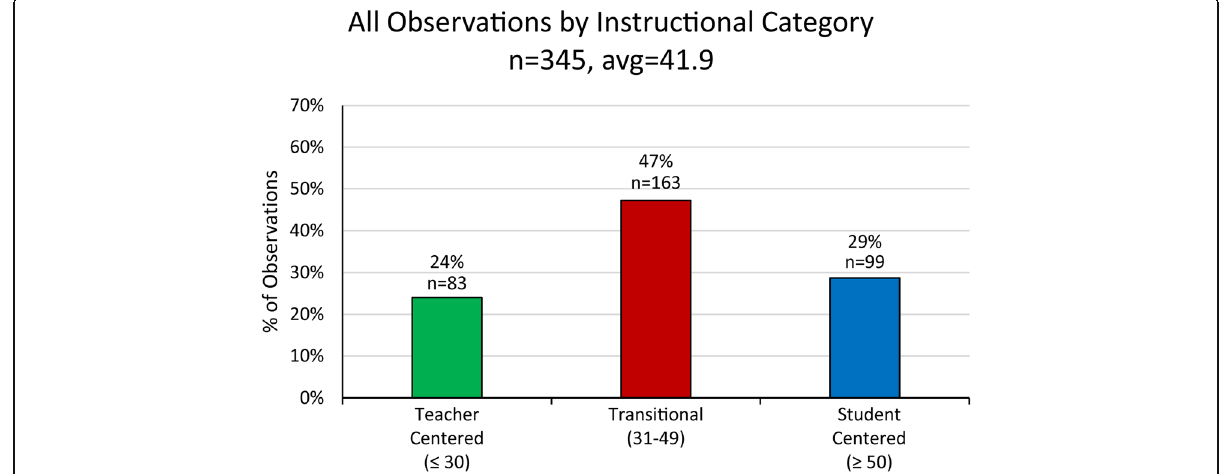
Fig. 4 Distribution of instructional category for all observations. Categories are student-centered ( ≥ 50) or transitional (31 – 49), and teacher- centered ( ≤ 30), from Budd et al.